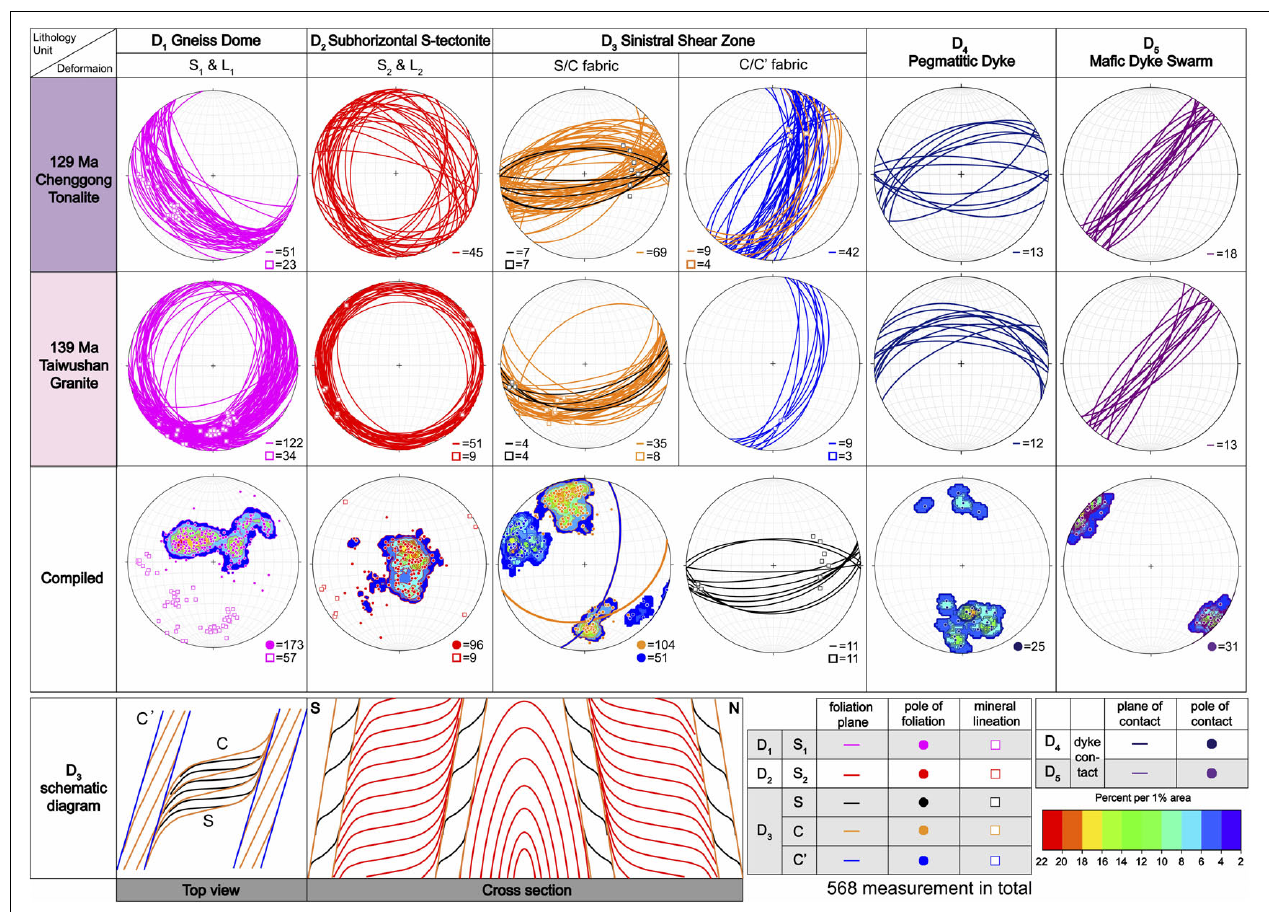
FIGURE 3 | Equal-area southern hemisphere stereographic projections of structure measurement data from 139 Ma Taiwushan Granite and 129 Ma Chenggong Tonalite with D 3 schematic diagrams showing the structural relationships of D 2 and D 3 as well as S/C/C’ fabrics. Different colors represent different deformation fabrics. The pole of foliation is used to show the compiled structure data. The mean plane of the D 3 fabric (C and C’ surface) is plotted. The measurement data can be found in Supplementary Table S1